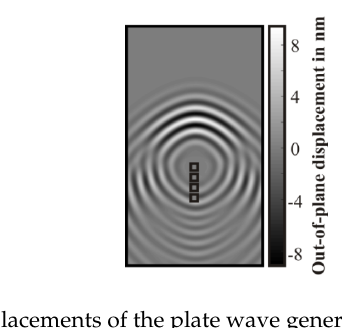
Figure 6. Out ‐ of ‐ plane displacements of the plate wave generated by a transducer array at t = 20 µs.